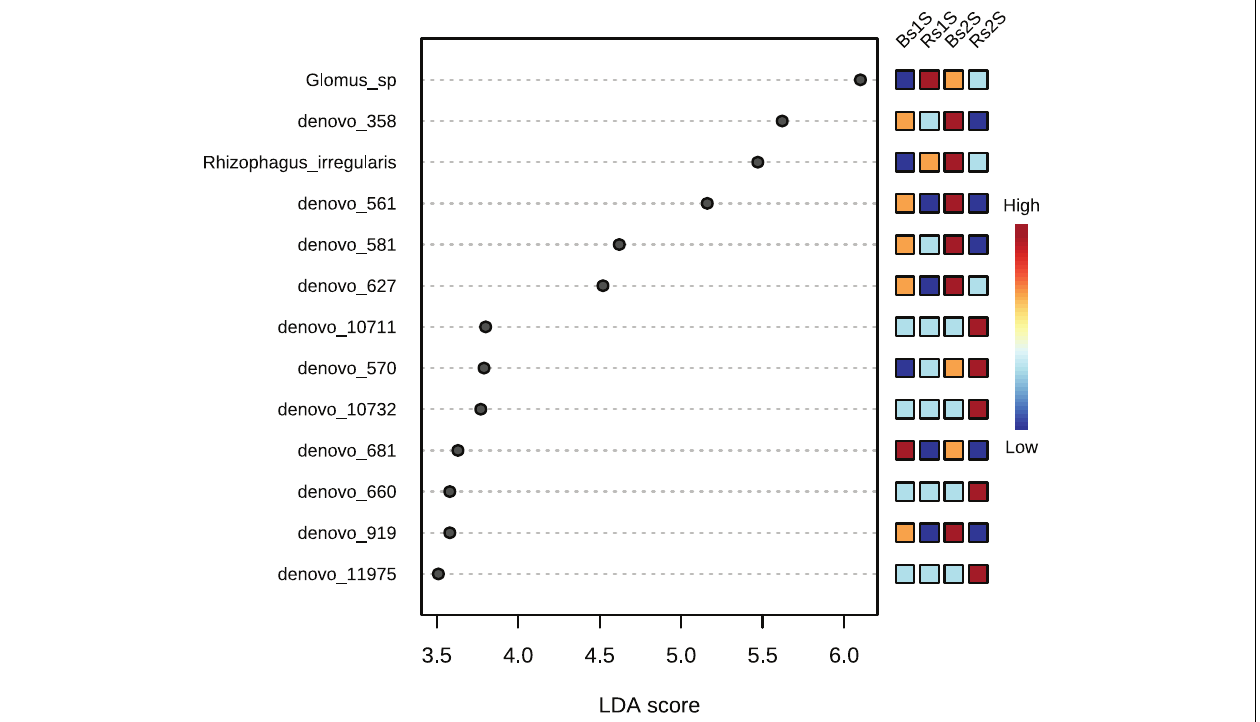
FIGURE 7 | Linear discriminant analysis–effect size (LDA–LEfSe) results using non-parametric factorial Kruskal–Wallis sum–rank test. Adjusted p -value cutoff = 0.05 and LDA score = 1.0; Glomus sp. (LDA score 6.1); de novo_ 358 – uncultured Archaeospora (LDA score 5.62), Rhizophagus irregularis (LDA score 5.47), de novo_ 561 – uncultured Archaeospora (LDA score 5.16), de novo_ 581 – uncultured Archaeospora (LDA score 4.62), de novo_ 627 – uncultured Archaeospora (LDA score 4.52), de novo_ 10711 – uncultured Glomus (LDA score 3.8), de novo_ 570 – uncultured Glomus (LDA score 3.79), de novo_ 10732 – Rhizophagus intraradices (LDA score 3.77), de novo_ 681 – uncultured Archaeospora (LDA score 3.63), de novo_ 660 – Rhizophagus irregularis (LDA score 3.58), de novo_ 919 – uncultured Archaeospora (LDA score 3.58), and de novo_ 11975 – uncultured Rhizophagus (LDA score 3.51). LEfSe analysis was performed with MicrobiomeAnalyst, a